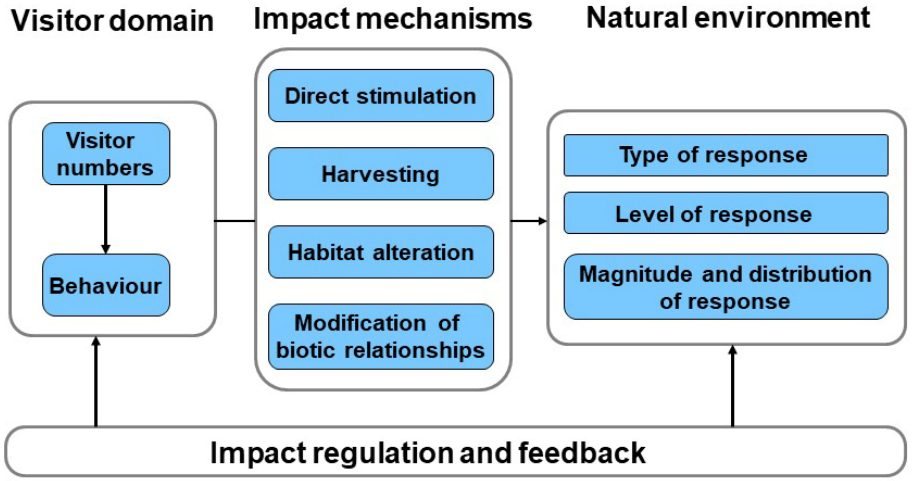
Figure 3. A conceptual framework of the relationship between nature-based tourists and recreationists and the natural